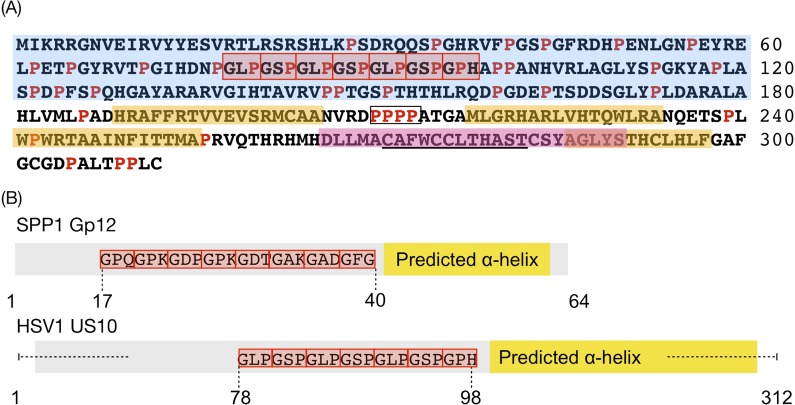
Sequence characterisation of pUS10.(A) Both previously described and newly identified features are indicated. Predicted disordered regions, α-helices, and transmembrane helices are highlighted in blue, yellow, and pink, respectively. CLRs are framed in red boxes. Prolines are highlighted in red. The 4-residue polyproline sequence is framed in a black box. The previously found consensus zinc finger sequence [68] is underscored. (B) Schematic comparison of the structural features of gp12 from bacteriophage SPP1 and pUS10 of HSV1. Protein sequences are shown in grey, CLRs as red boxes with the involved residues annotated, and predicted α-helical regions are highlighted as yellow boxes. CLR, collagen-like repeat; gp12, glycoprotein 12; HSV1, herpes simplex virus type 1; pUS, protein in unique short region; SPP1, secreted phosphoprotein 1.